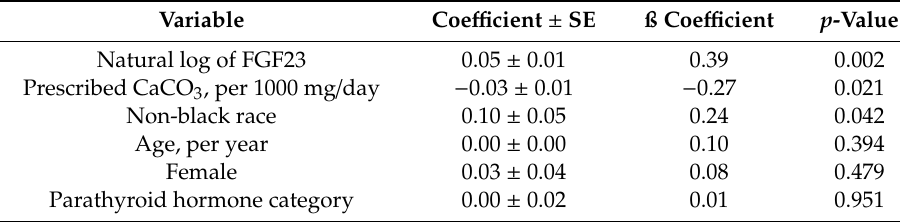
Table 4. Simple multivariable model to predict serum calcium (adjusted r 2 = 22%).